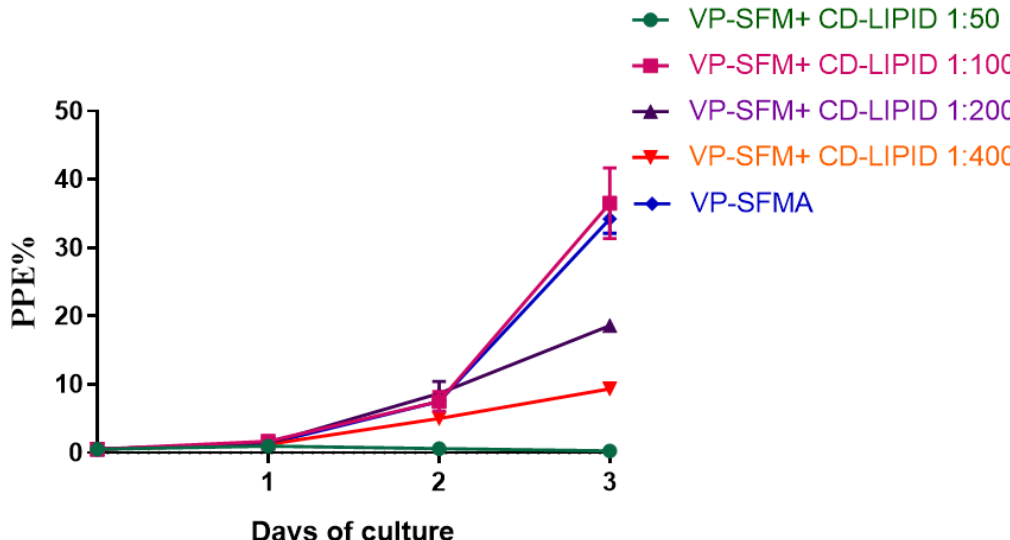
Figure 2. In vitro culture of B. duncani in VP-SFM supplemented with different concentrations of CD Lipid mixture. Mean values from three separate experiments using triplicate wells for each tested condition were represented.